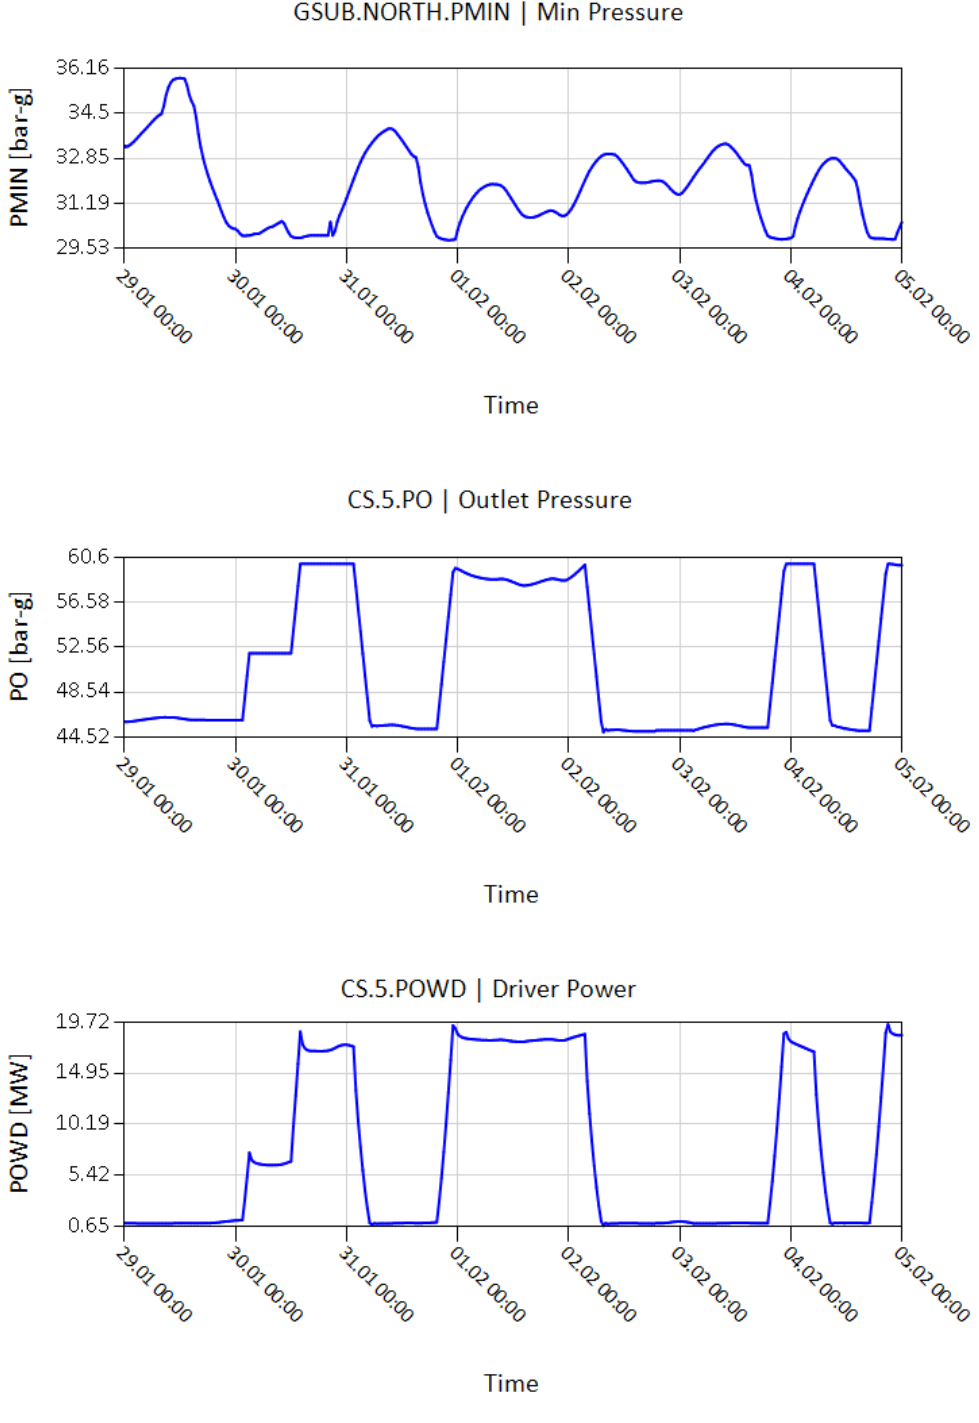
Figure 11. Time evolution of minimum pressure in subsystem GSUB.NORTH and outlet pressure and driver power for compressor station CS.5 for DA simulation for Q1 and for a 20% wind and solar